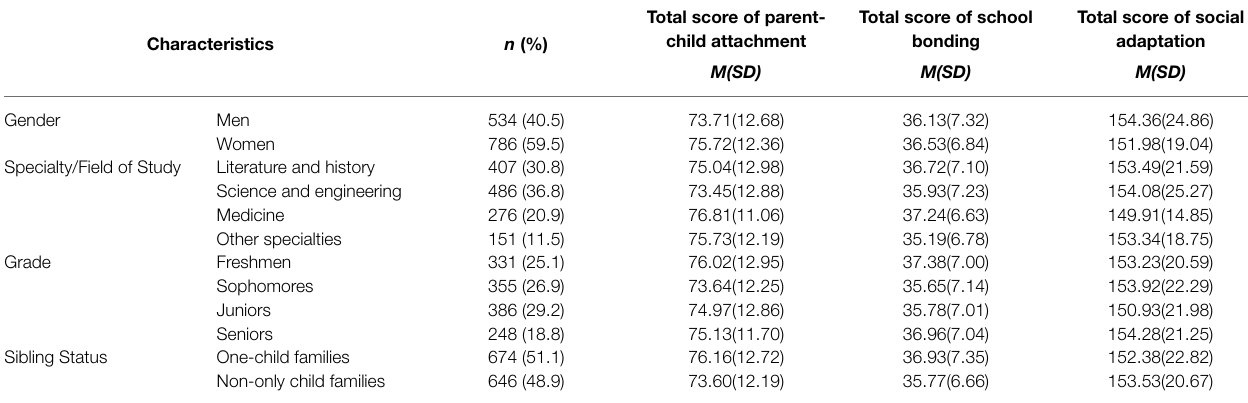
TABLE 1 | Samples of characteristics ( N = 1,320).